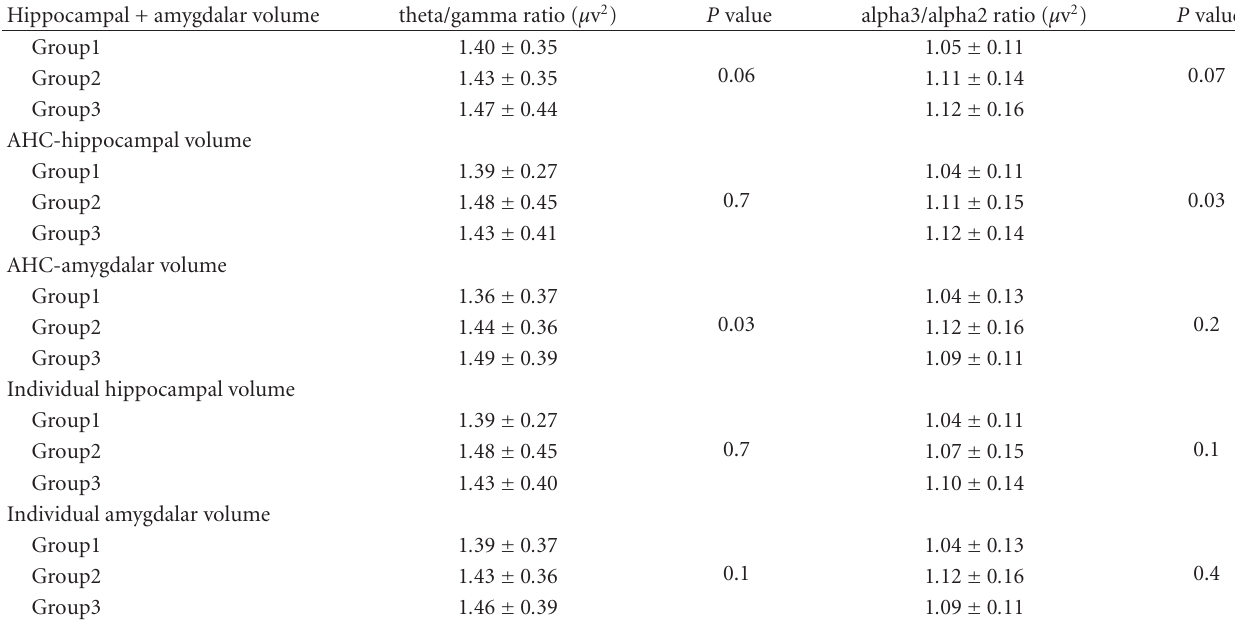
Table 4: Relative power band ratios in amygdalo-hippocampal complex (AHC), hippocampal and amygdalar atrophy. Hippocampal and amygdalar volumes refer to the whole amygdalo-hippocampal complex (AHC) and are singularly considered (individual). Hippocampal + amygdalar